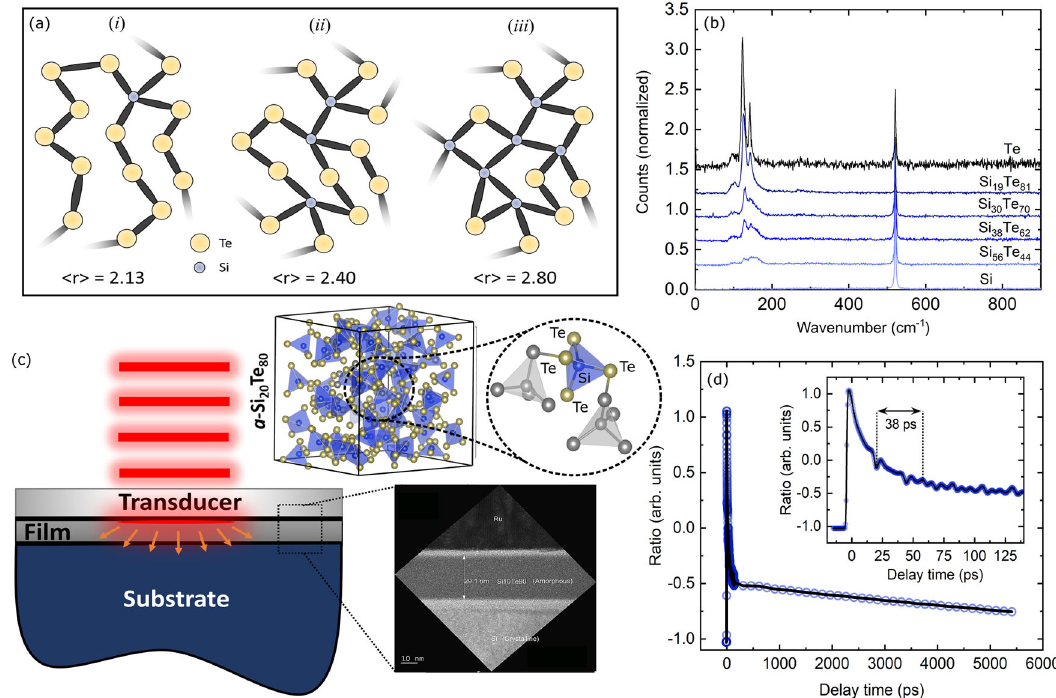
Fig. 1 The structure and characterization of amorphous SiTe fi lms. a Schematics of amorphous networks and their corresponding coordination number < r > with a total of 15 atomic sites for different Te to Si ratios, representing various topological regimes: (i) under-constrained network, (ii) stress-free network, and (iii) over-constrained network. b Raman spectra for SiTe at different Te concentrations. The sharp silicon peak is the effect of the substrate and is not associated with the thin- fi lm properties. c Illustration of the TDTR measurement, a representative atomic structure of a -Si 20 Te 80 with 300 atoms forming randomly oriented tetrahedrons where each Si is bonded to four Te atoms, and a TEM showing the relevant layers in a -Si 11 Te 89 . d Representative TDTR data for 40 nm thick a -Si 19 Te 81 . The inset shows the picosecond acoustics measurements where the distances between the peaks and troughs in the measured TDTR data are related to the time it takes for acoustic waves traveling at the speed of sound to traverse the a -Si 19 Te 81 fi